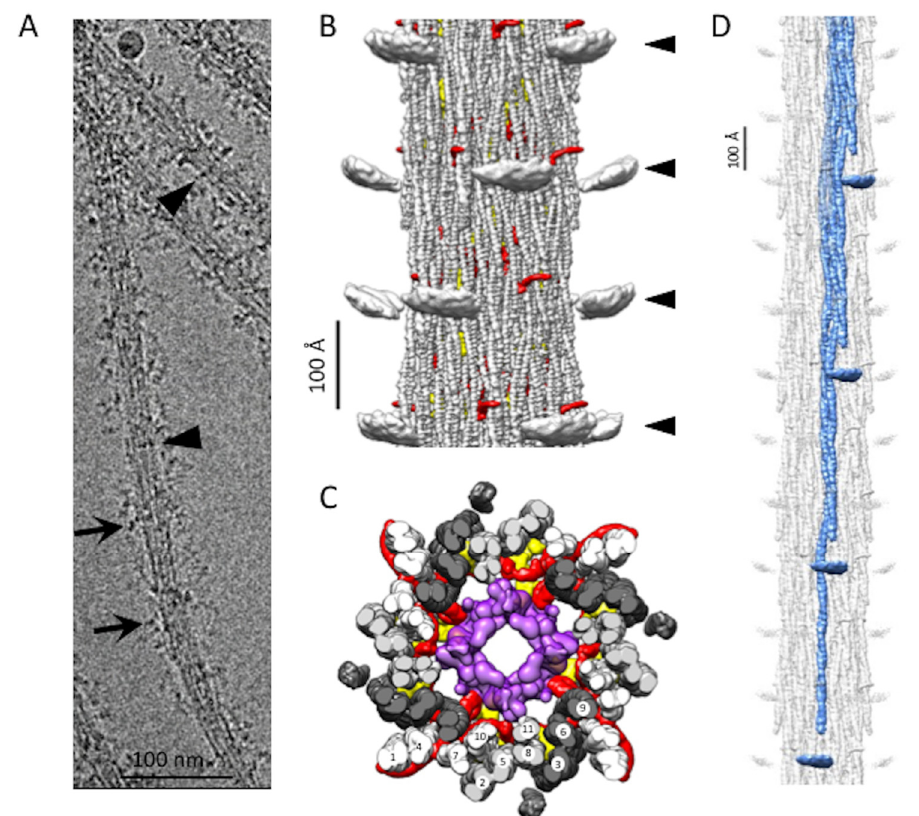
Figure 1. Bombus thick filament reconstruction. ( A ) An electron micrograph of a thick filament. The longitudinal lines in the thick filament backbone are produced by the coiled-coil domains of myosin and paramyosin. The disordered dark transverse densities marked by black arrows are possibly the myosin heads. Occasionally, transverse densities (arrowheads) are observed, which are reminiscent of the Free Heads in Lethocerus thick filaments [8]. ( B ) The reconstruction shows three full crowns of the Bombus thick filament. The “floating” densities (arrowheads) are the average positions of the myosin heads when helical and 4-fold symmetry are enforced. Non-myosin density, flightin (red) is visible extending from the backbone surface. ( C ) Transverse view through one crown showing the relative positions of flightin (red), myofilin (yellow), putative paramyosin (purple) and the curved layers (dark gray, light gray and white). Note that both flightin and myofilin have folded domains on the inside surface of the annulus of myosin tails that could contact paramyosin. ( D ) The 12-crown extended filament, with one curved layer highlighted in blue. The floating densities are not connected to the myosin tail due to the disorder in the proximal S2.